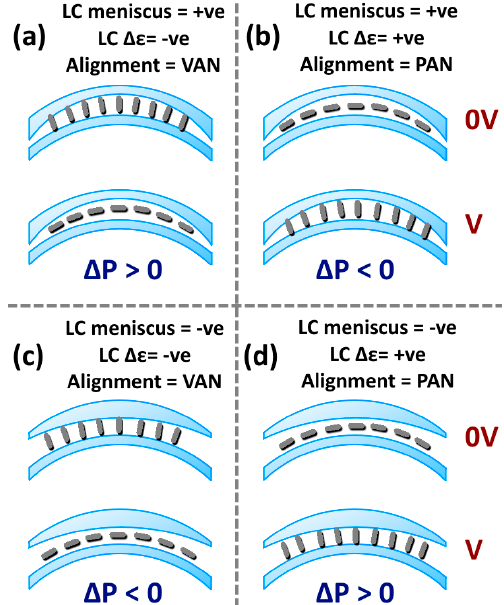
Figure 6. Schematics of how the different possible LC lens shape and dielectric permittivity influence how the device functions. Captions ( a , b ) have a positive meniscus LC